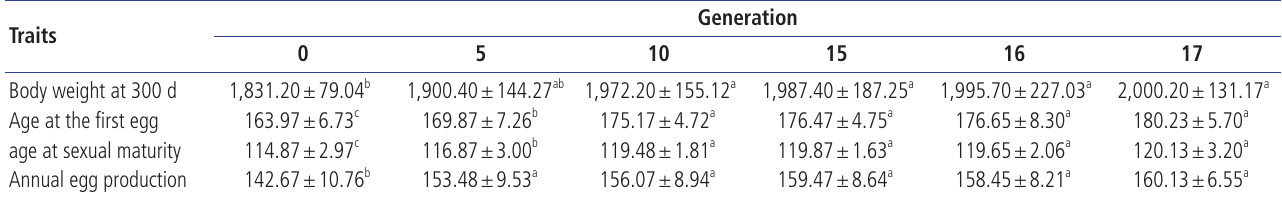
Table 5. Means and standard deviation for phenotypic traits by generation